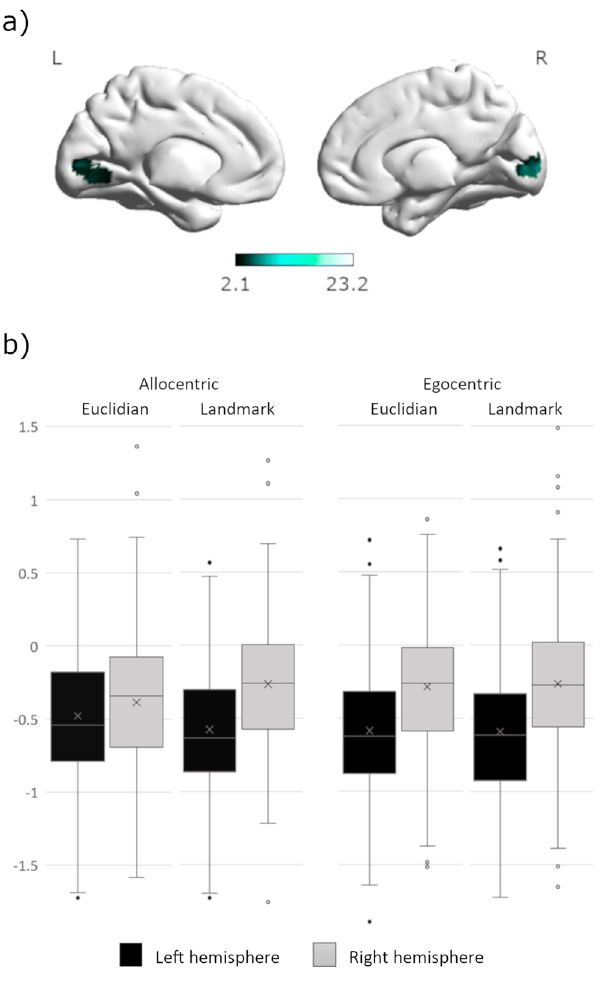
Fig. 2 Interactive effect between perspective and strategy in the lingual gyrus. a Differential activation of the left and right hemisphere in the lingual gyrus. b In the left hemisphere, Euclidian navigation yielded less deactivation than landmark navigation for allocentric compared to egocentric instructions. In the right hemisphere, the opposite pattern was observed. Error bars represent standard errors, N =